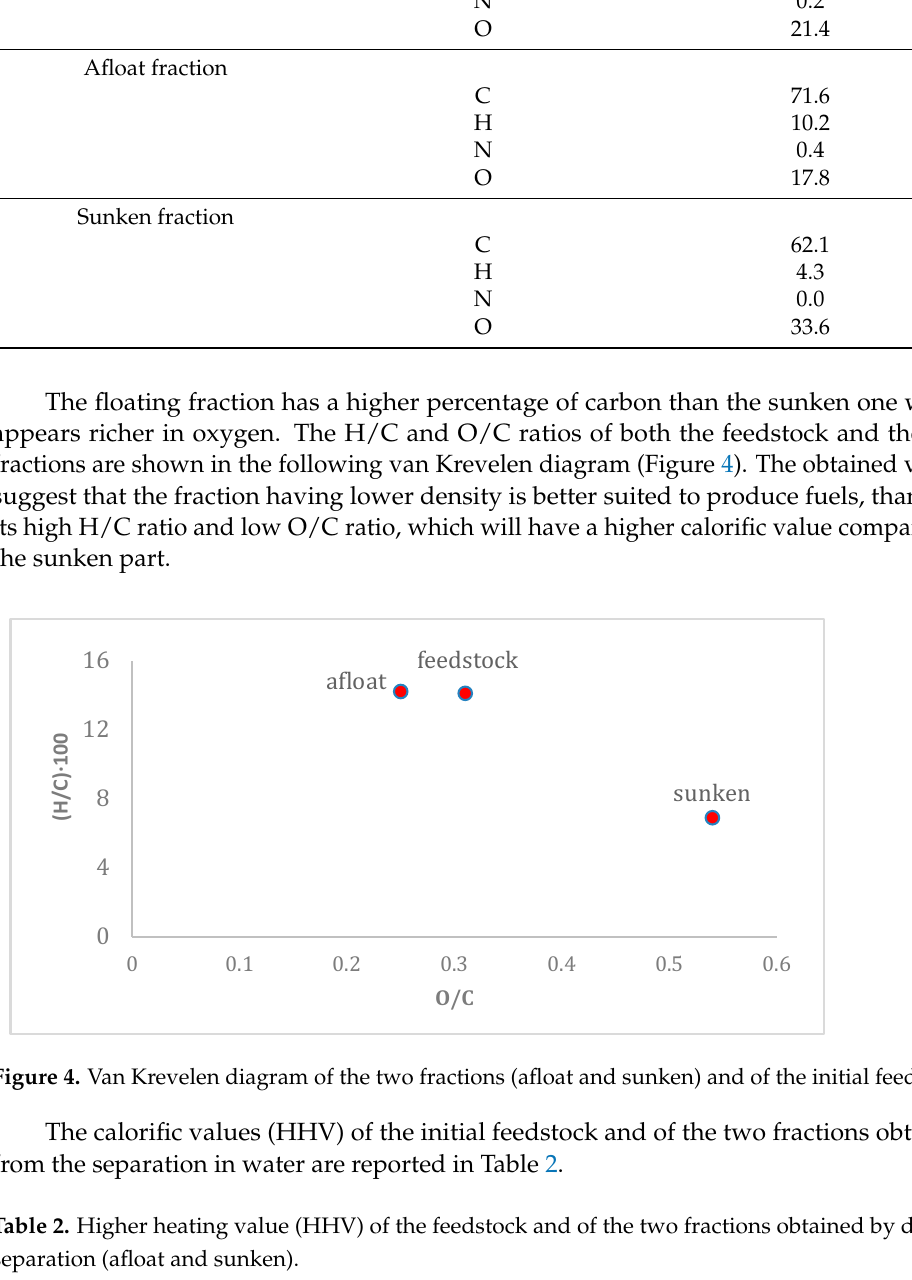
Table 1. Elemental analysis on dry basis of the feedstock and of the two fractions obtained by den- sity separation (afloat and sunken).